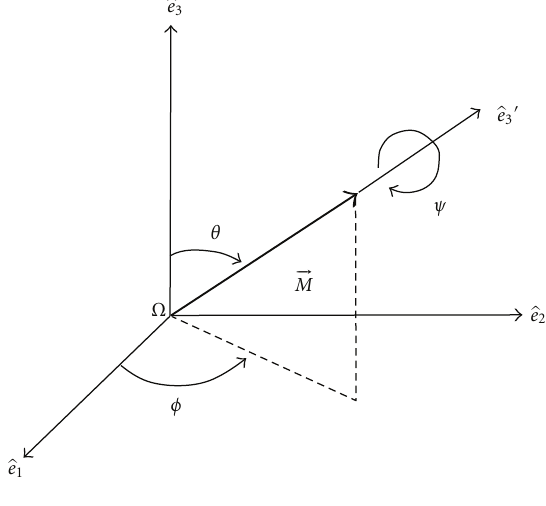
Figure 1: Reference frame used in the